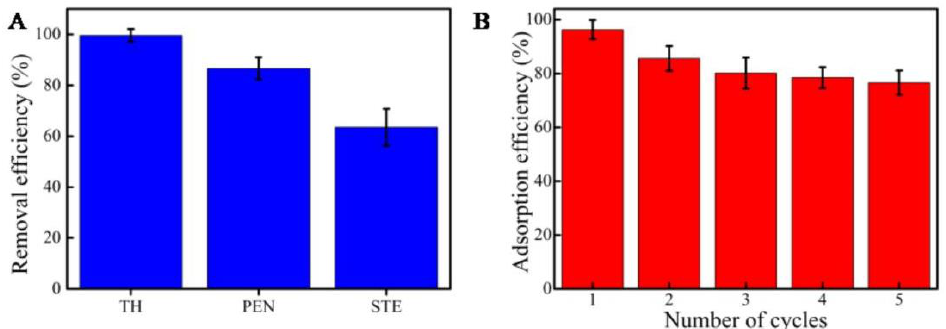
Figure 7. Removal efficiency and reuse of MCNs for adsorption of antibiotics. ( A ) Removal efficiency. ( B ) Number of cycles. All the experiments were performed three times.